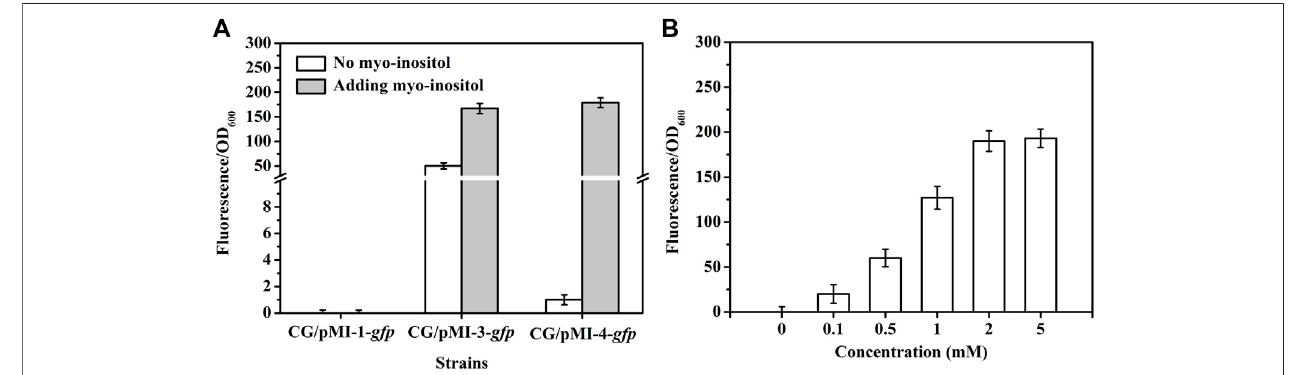
FIGURE 3 | GFP fl uorescence intensities in C. glutamicum strains. (A) GFP fl uorescence intensities in C. glutamicum strains harboring different vectors in the absence(white) orpresenceofmyo-inositol(gray).CG/pMI-1- gfp ,CG/pMI-3- gfp ,and CG/pMI-4- gfp indicate C.glutamicum /pMI-1- gfp , C.glutamicum /pMI-3- gfp ,and C.glutamicum /pMI-4- gfp ,respectively. C.glutamicum /pMI-1- gfp wasusedasacontrol.Inthisstrain,GFPwasnotexpressedbecausepMI-1- gfp lacksapromoter.The vectorpMI-3- gfp containsP iolT1 and iolR cassettewithitsnativepromoterP iolR ,andthevectorpMI-4- gfp containsP iolT1 and iolR q cassettewiththeconstitutiveP tuf . (B) The effect of myo-inositol concentrations on GFP expression in C. glutamicum /pMI-4- gfp . C. glutamicum /pMI-4- gfp was induced by myo-inositol at different concentrations.